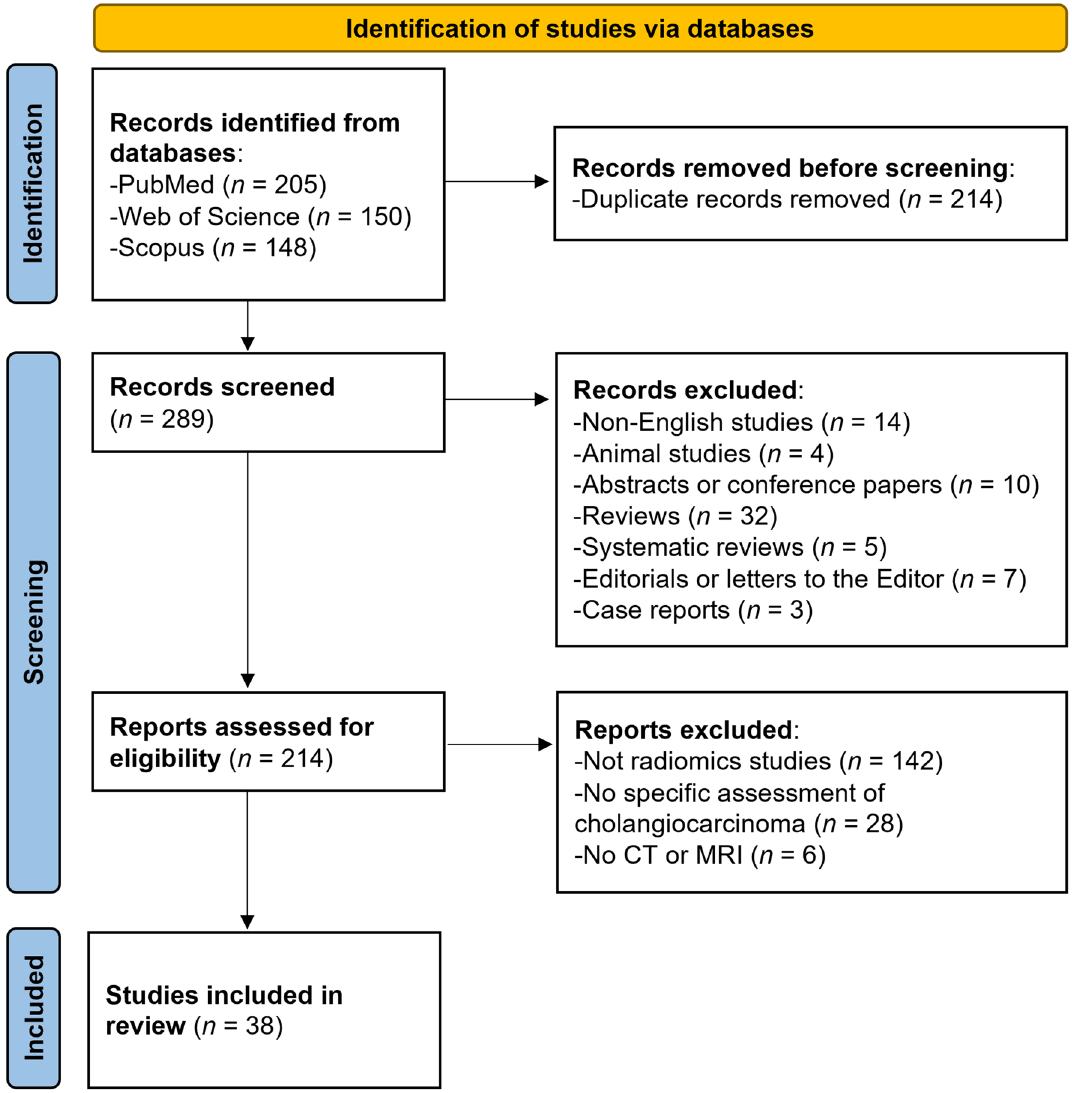
Fig. 1 Flow diagram of the study selection